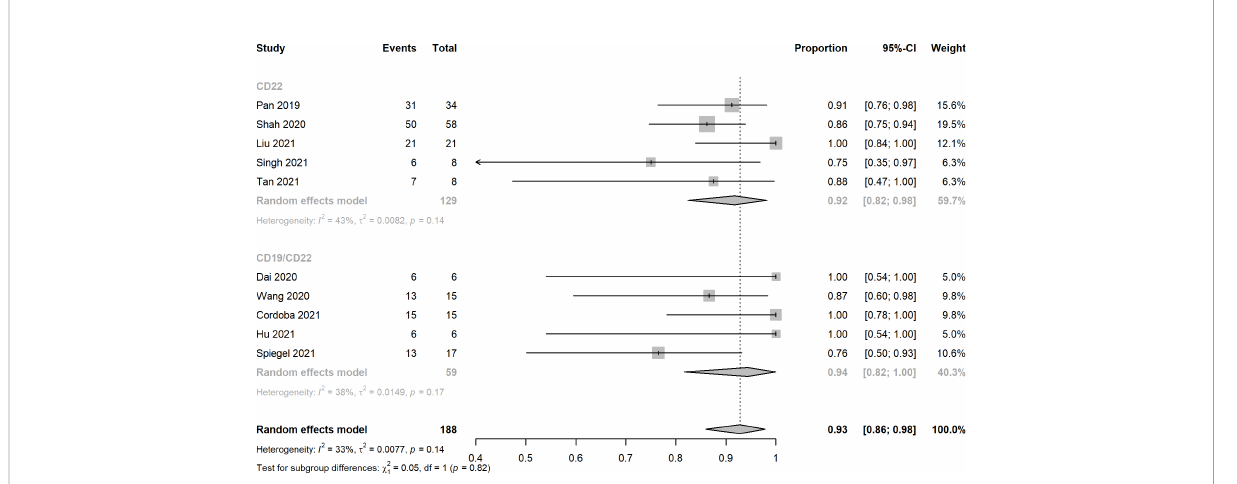
FIGURE 4 Forest plots of cytokine release syndrome rates of CD22 and CD19/CD22 targeted CAR-T cell therapies for relapsed or refractory